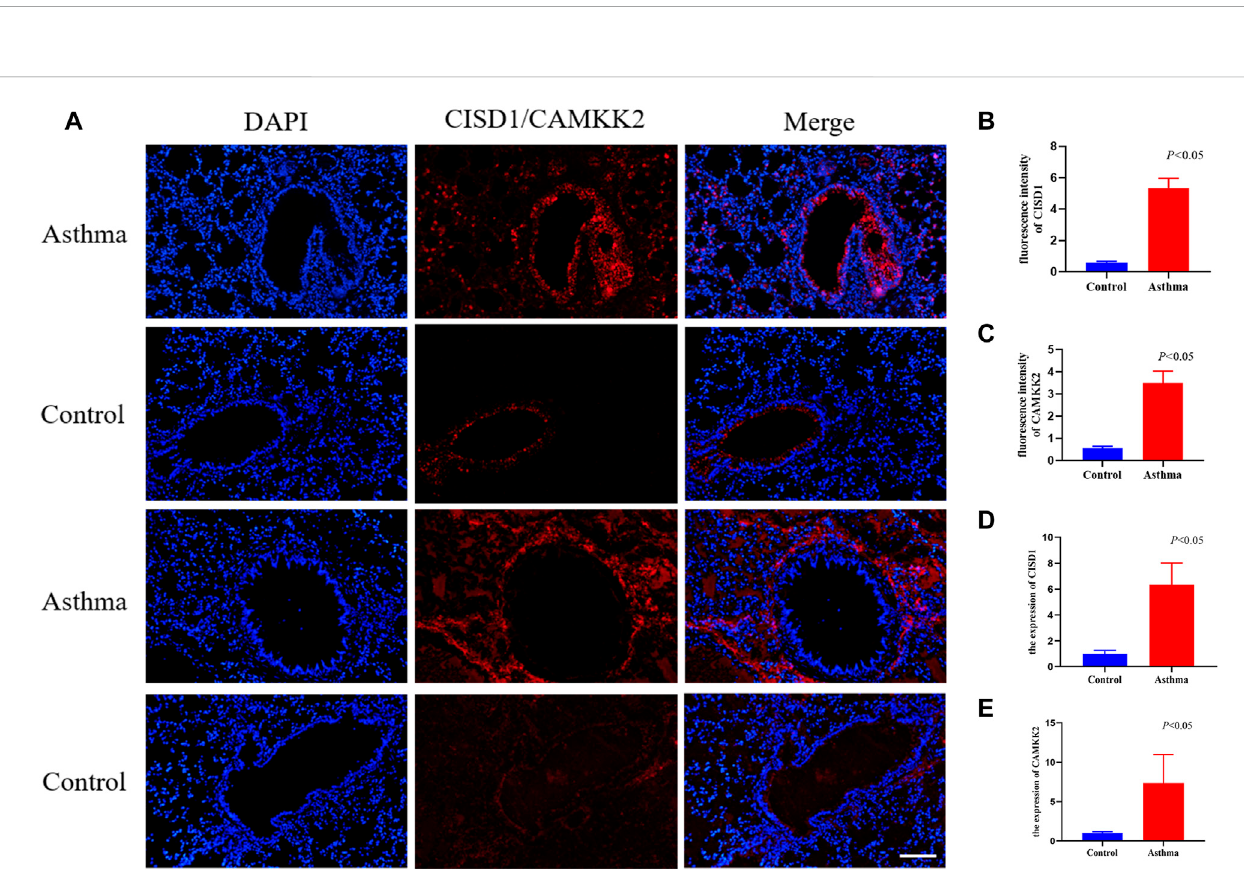
FIGURE 6 The result of validation by immuno fl uorescent staining and RT-qPCR in mouse models (A – C) immuno fl uorescent staining images of lung tissues and quanti fi cation of fl uorescence intensity, Nucleus (blue), CISD1/CAMKK2 (red), scale bar, 500 um, ( n = 4 per group) (D – E) The expression of CISD1 and CAMKK2 veri fi ed by RT-PCR in the OVA model ( n = 4 per